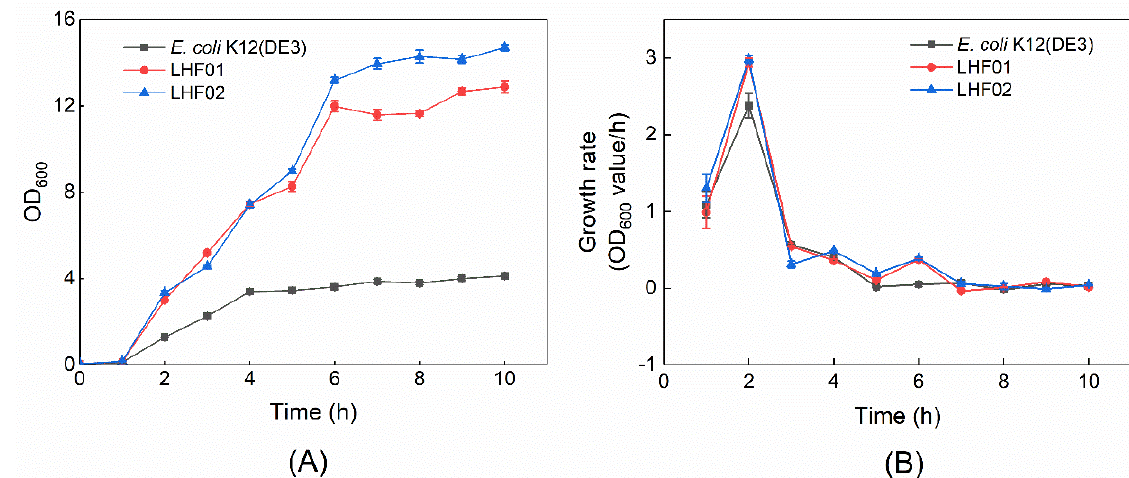
Figure 2. The cell growth curve ( A ) and growth rate ( B ) of V. alginolyticus and E. coli . V. alginolyticus strains were cultivated in TYS medium supplemented with 20 g/L glycerol, while E. coli K12 (DE3) was cultivated in LB medium. Data are expressed as averages and standard deviations of three parallel experiments. The growth rate was calculated using OD 600 values according to the following equation: µ = (lnX2 − lnX1)/(t2 − t1). X1 and X2 refer to the OD 600 values of cell cultures at culture time (t) t1 and